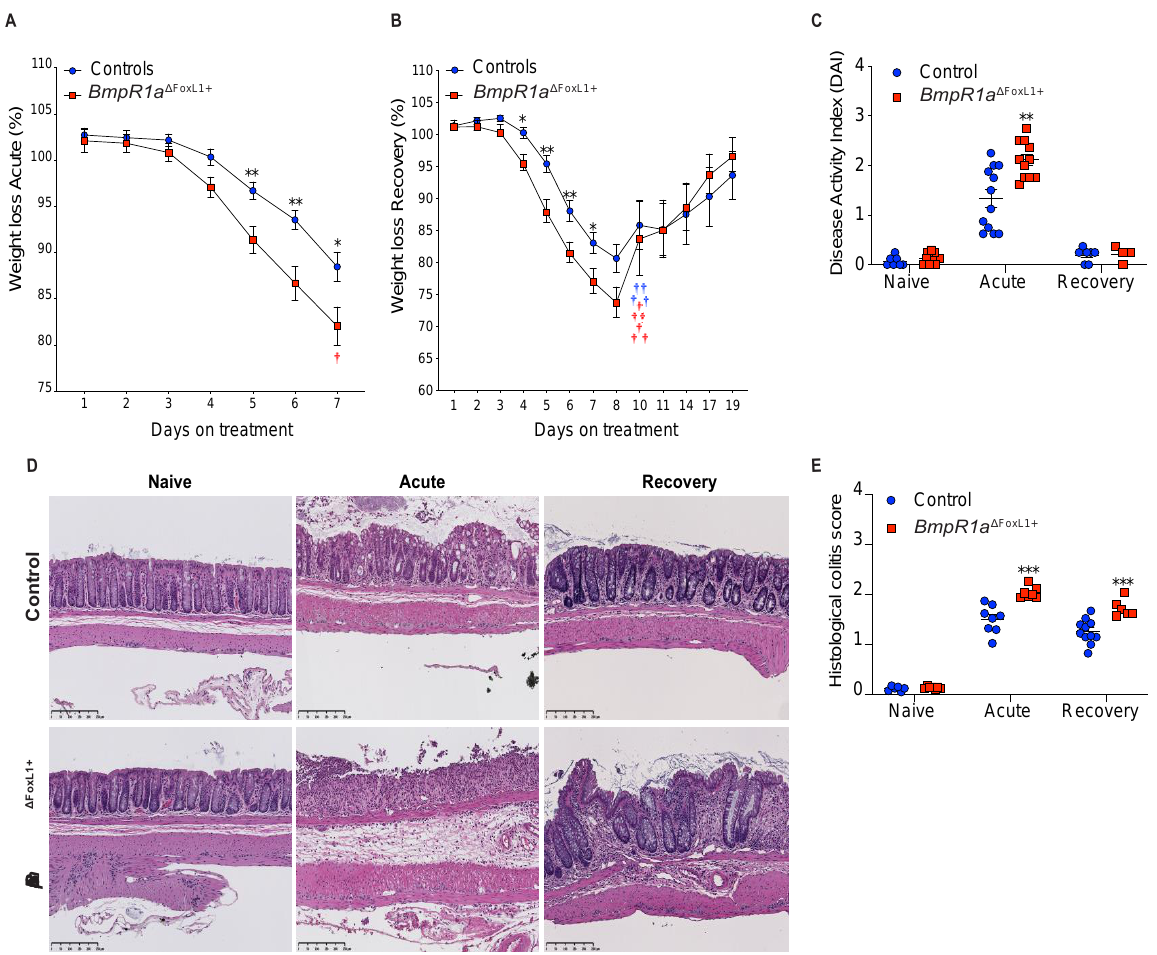
Figure 1. Loss of BMP signalling in telocytes predisposes mice to severe experimental colitis. ( A ) BmpR1a Δ FoxL1+ mice (red squares) had greater weight loss than control mice (blue circles) following the induction of acute experimental colitis and ( B ) the subsequent recovery phase ( N = 10). ( C ) DAI analysis revealed a significant DAI increase in mutant mice only during the acute phase. ( D ) H&E staining shows normal mucosa architecture under naive condition in all groups. During the acute phase, control mice presented crypt erosion but the epithelial layer was preserved while BmpR1a Δ FoxL1+ mice presented a complete loss of their epithelial sheet. After recovery, control mice showed a restored mucosa, whereas BmpR1a Δ FoxL1+ mice still presented immune infiltration and regions with crypt distortion. ( E ) Histological scores reveal a significant increase in mutant mice in both treatments. Data are expressed as the mean ± SEM ( N = 19 – 20). * p < 0.05; ** p < 0.01; *** p < 0.001 analysed by Mann – Whitney test. Scale bar: 250 μm. † Animals that died during the experiment.